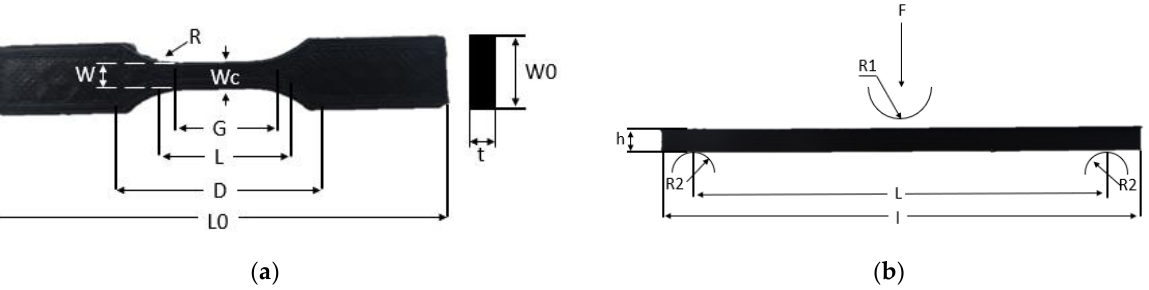
Figure 1. ( a ) Tensile specimen geometry (based on ASTM D638.14) and ( b ) Flexural specimen geometry (based on ISO 14125). Table 3. Tensile and flexural specimen dimensions.